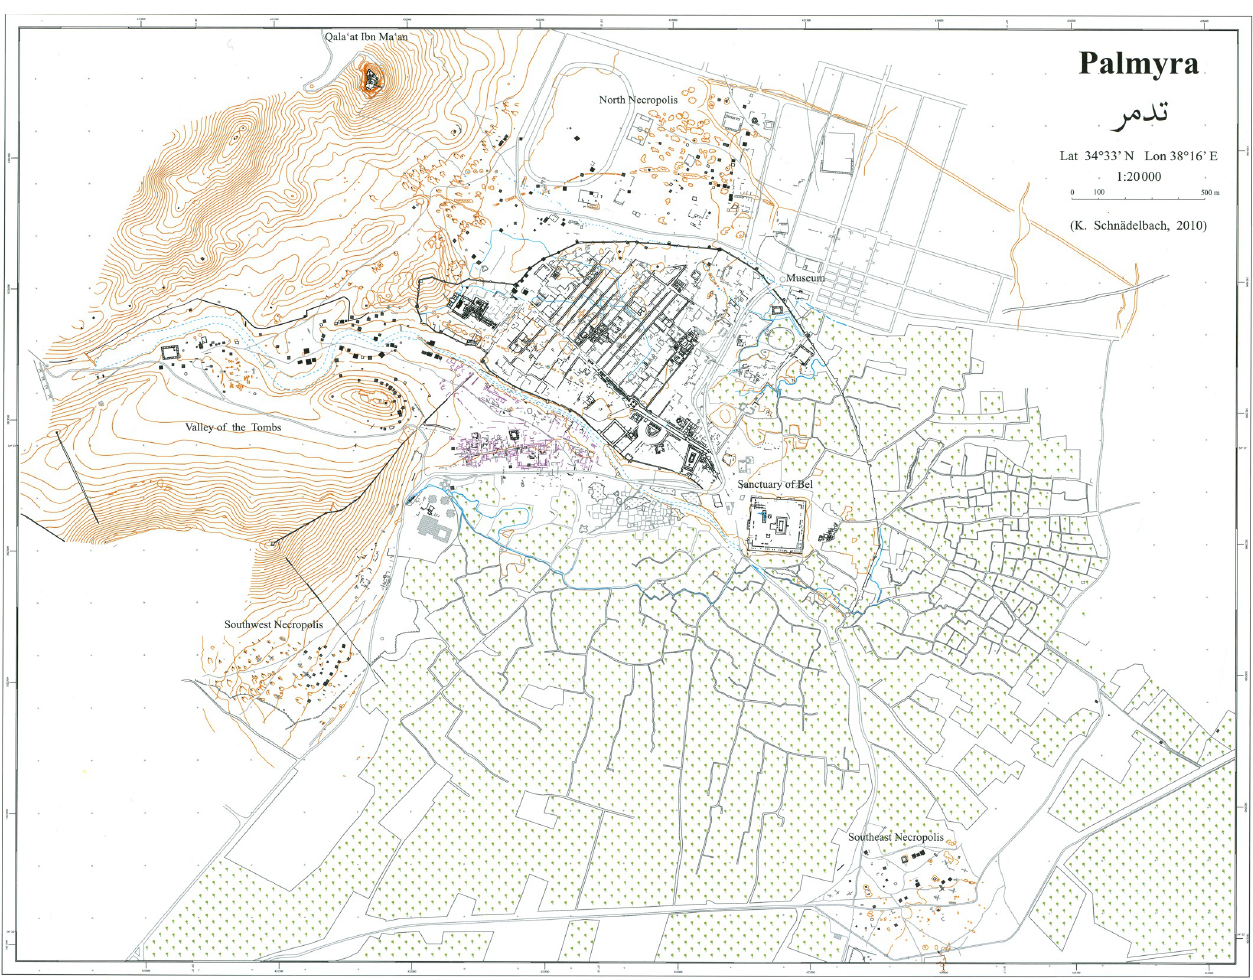
Fig 2. Map of Palmyra and immediate environs. Reprinted with permission by Klaus Schna¨delbach, after Topographia Palmyrena, Damascus 2010.